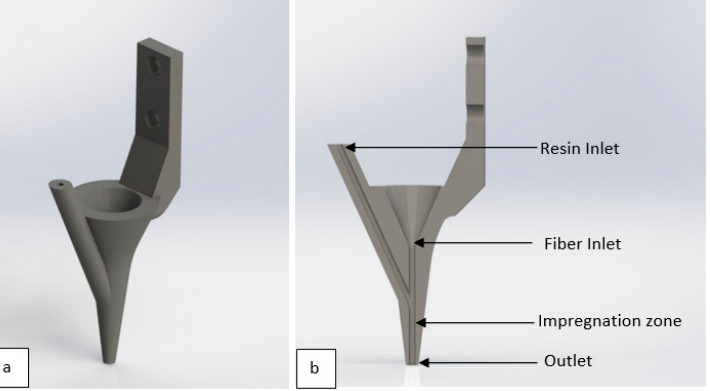
Figure 1. ( a ) Three-dimensional view of printing nozzle. ( b ) Cross-section of printing nozzle.